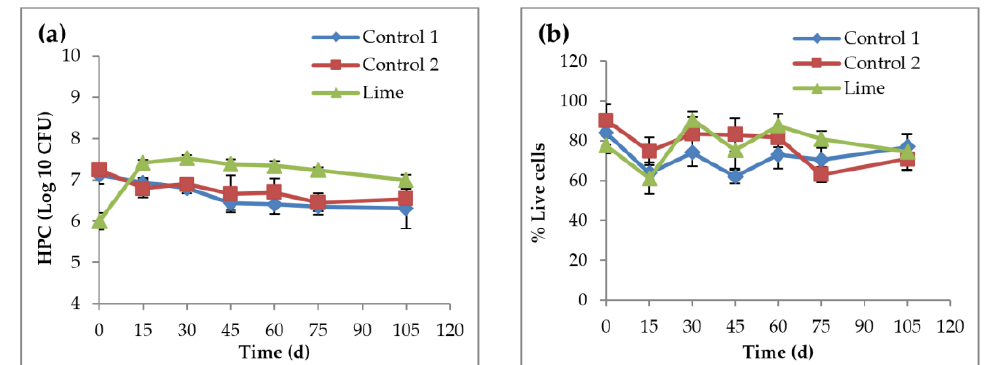
Figure 5. HPC, represented by CFU ( a ) and the percentage of live cells in soil reactors ( b ) over time. Control 1 is the soil reactor that received untreated sludge with no nanoparticles, control 2 is the soil reactor that received untreated sludge with 2 mg AgNPs/g TS sludge, and lime is the soil reactor that received lime treated sludge with 2 mg AgNPs/g TS sludge.